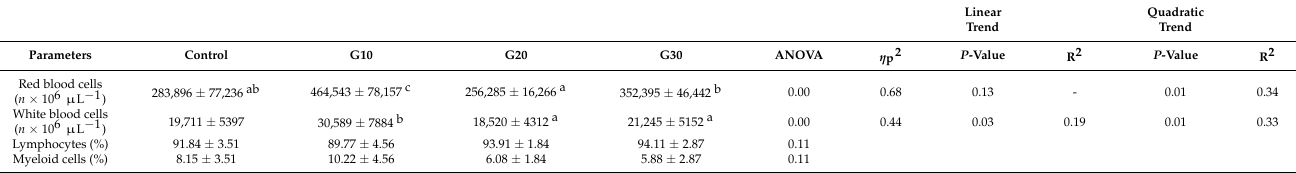
Table 5. Haematological parameters of Eurasian perch fed with feeds supplemented with garlic powder.